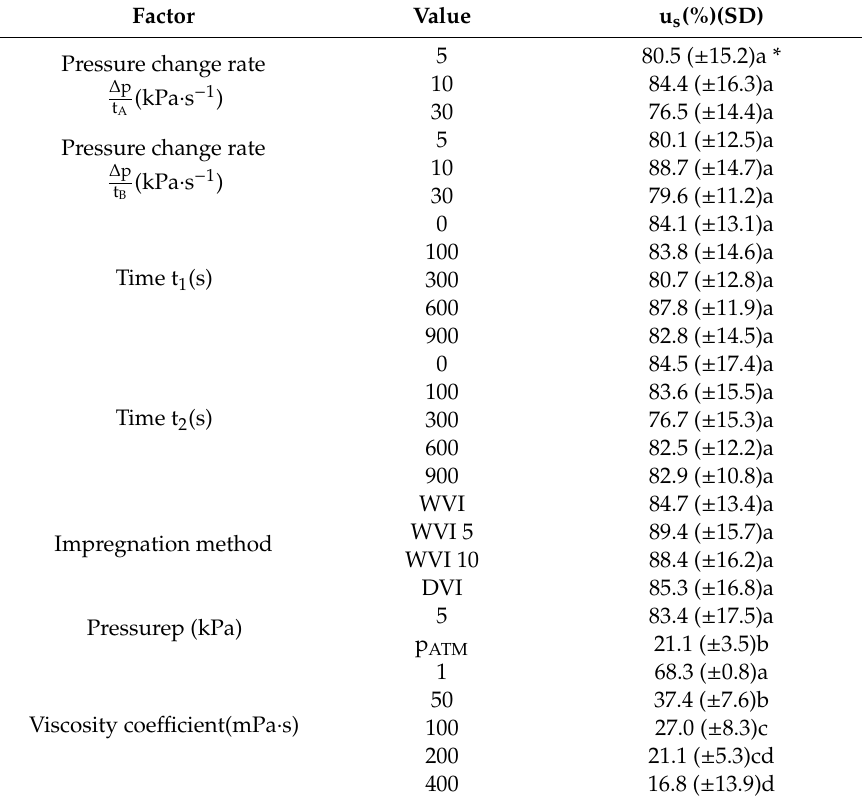
Figure 10. Apple tissue impregnated in di ff erent conditions using a staining solution with a viscosity coe ffi cient η = 1 mPa · s and η = 400 mPa · s, 5(WVI 5)—fivecycles of WVI at 5 kPa, 5(WVI 10)—10 cycles of WVI at 5 kPa. Table 1. Analysis of the significance of the impact of the analyzed factors on the u s value. Mean values marked with the same letter in columns do not di ff er significantly (p ≤